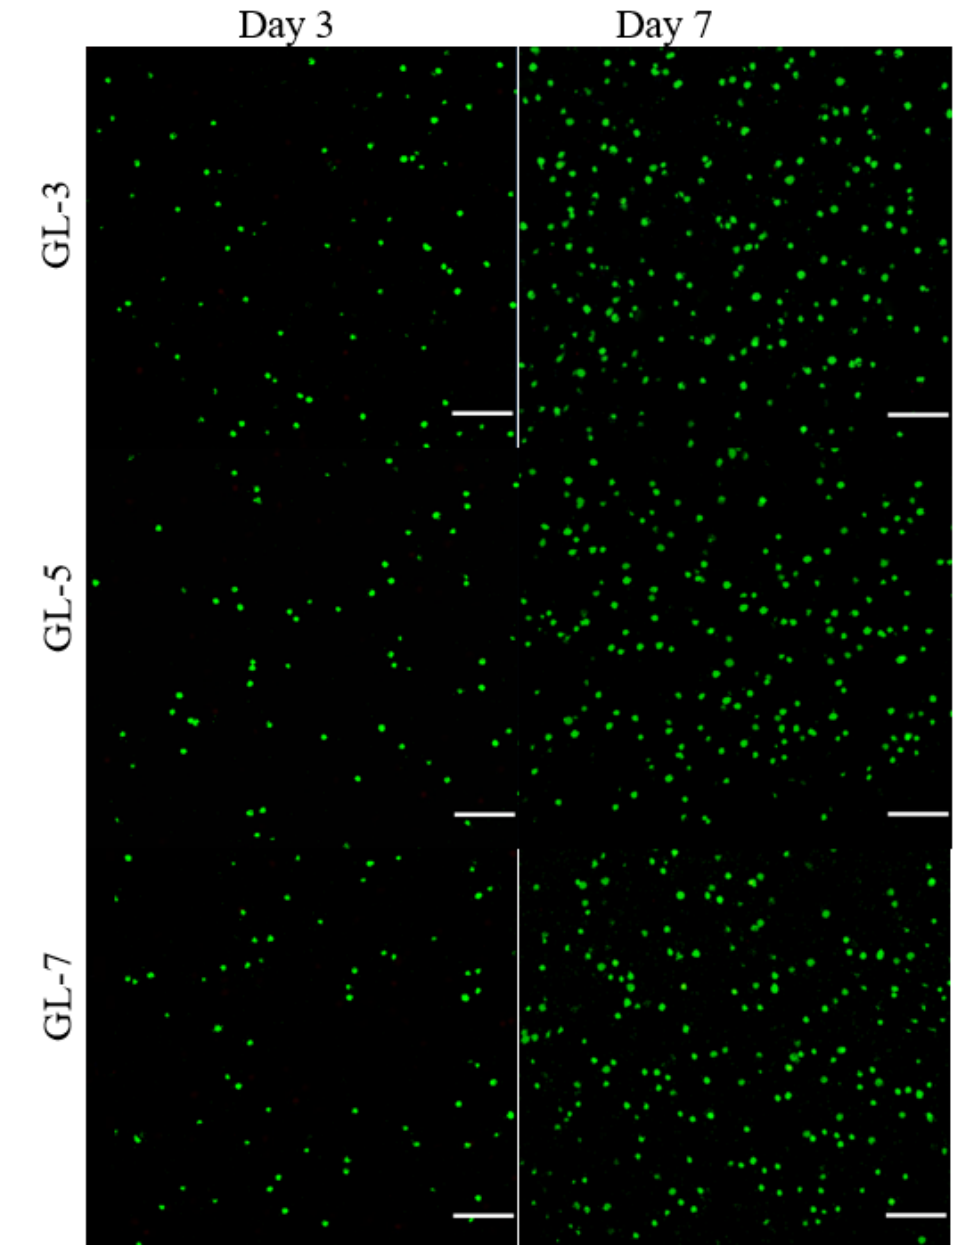
Figure 5. Confocal images for stained chondrocyte cells (green: viable cells; red: dead cells; scale bar: 100 µ m). Figure 6A delineates results for the cell proliferation in different gel matrices.